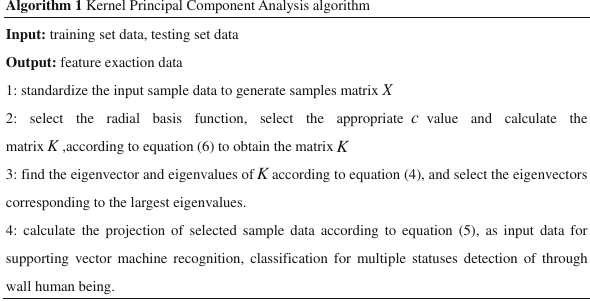
Algorithm 1 Kernel Principal Component